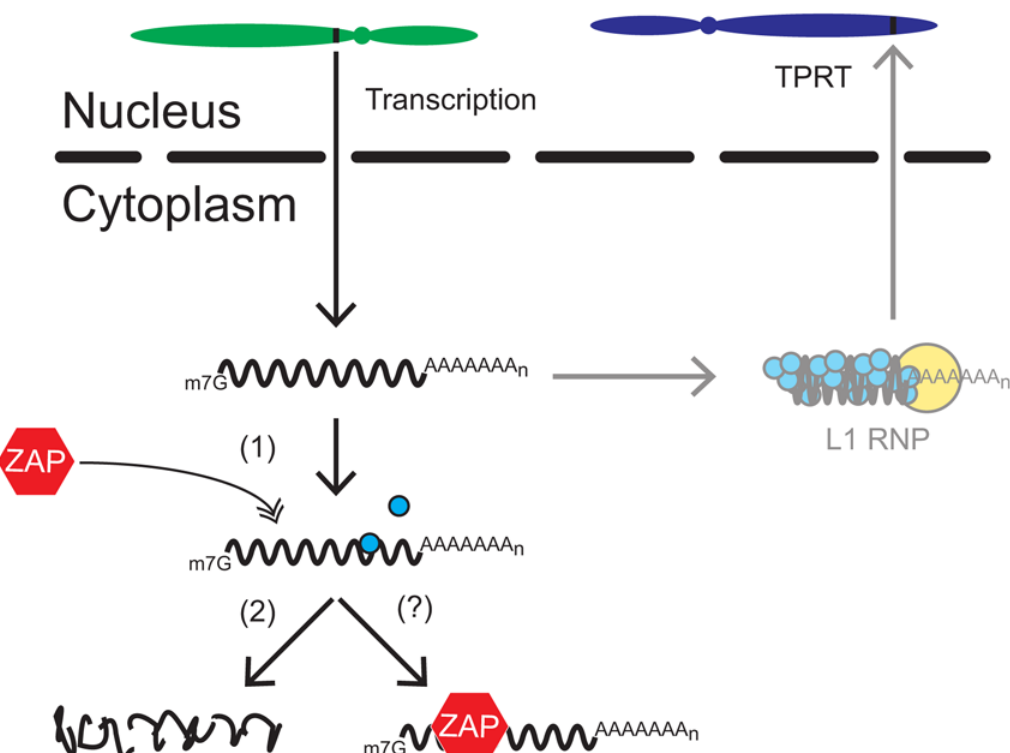
Fig 7. A working model for how ZAP restricts L1 retrotransposition. Once a genomic L1 (black rectangle located on the green chromosome) is transcribed, the resultant bicistronic L1 mRNA is exported to the cytoplasm for translation. L1 ORF1p (blue circles) and ORF2p (yellow circle) bind back to L1 mRNA to form an L1 RNP. The L1 RNP gains access to the nucleus where a new L1 copy is inserted into genomic DNA by the process of TPRT (black rectangle located on the blue chromosome). In ZAP-mediated restriction, ZAP (red hexagon) interacts with L1 mRNA in the cytoplasm (1), which we propose leads to the destabilization of L1 RNA (2) and/or a block in translation (?) through the recruitment of other cellular factors ( e . g ., SG associated proteins, RNA decay proteins) involved in RNA